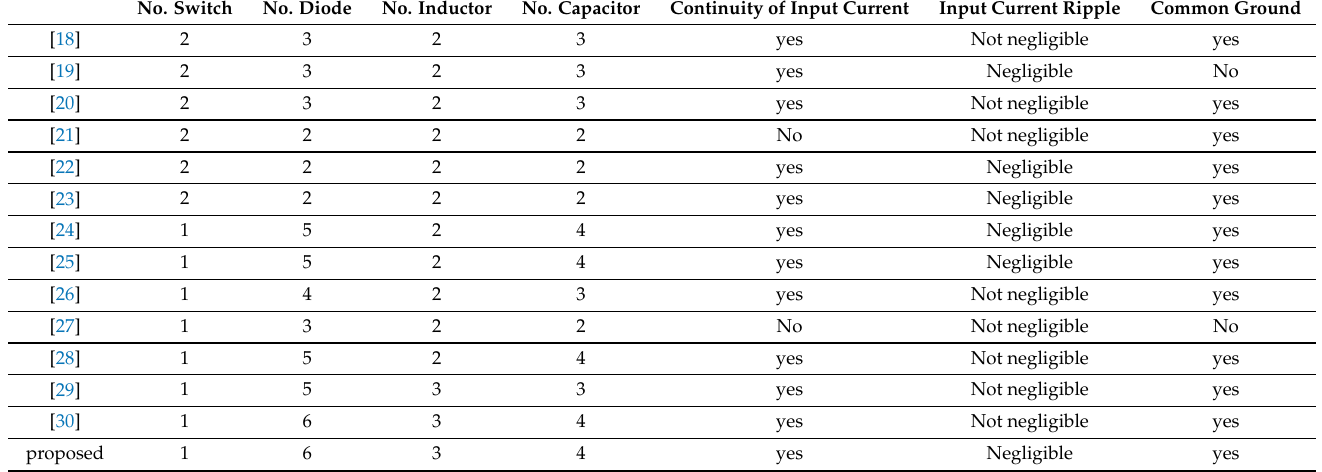
Table 1. Comparison of Voltage/current